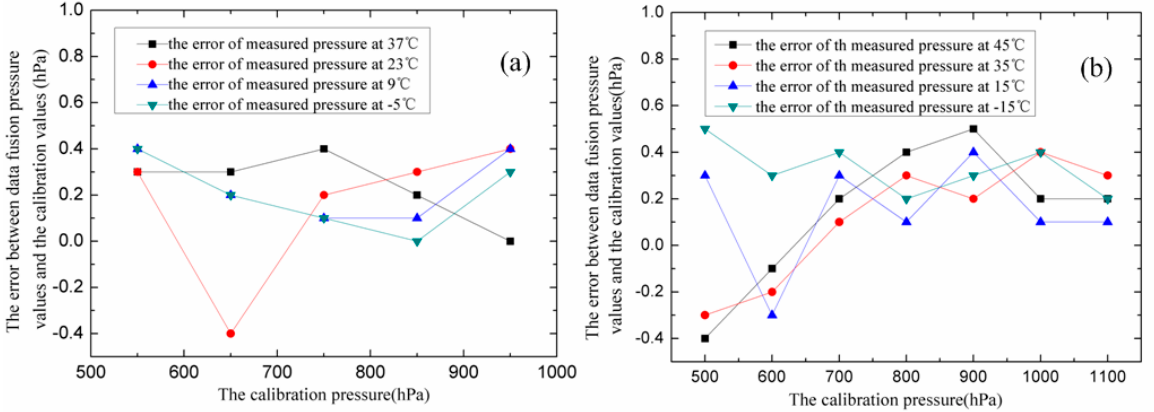
Figure 11. The errors between the corrected pressures of the digital MEMS-array pressure transmitter by data fusion and the calibration pressures from the Fluke pressure generator at different temperatures. ( a ) After the storage for 3 months. ( b ) After the storage for 6